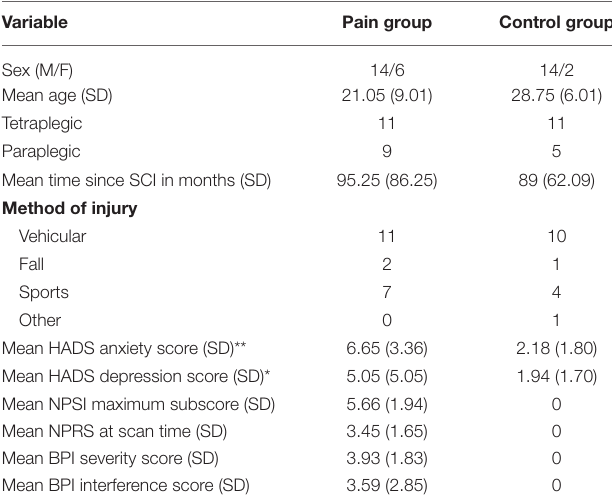
TABLE 1 | Groupwise summary of demographics, SCI statistics, and anxiety, depression, and pain